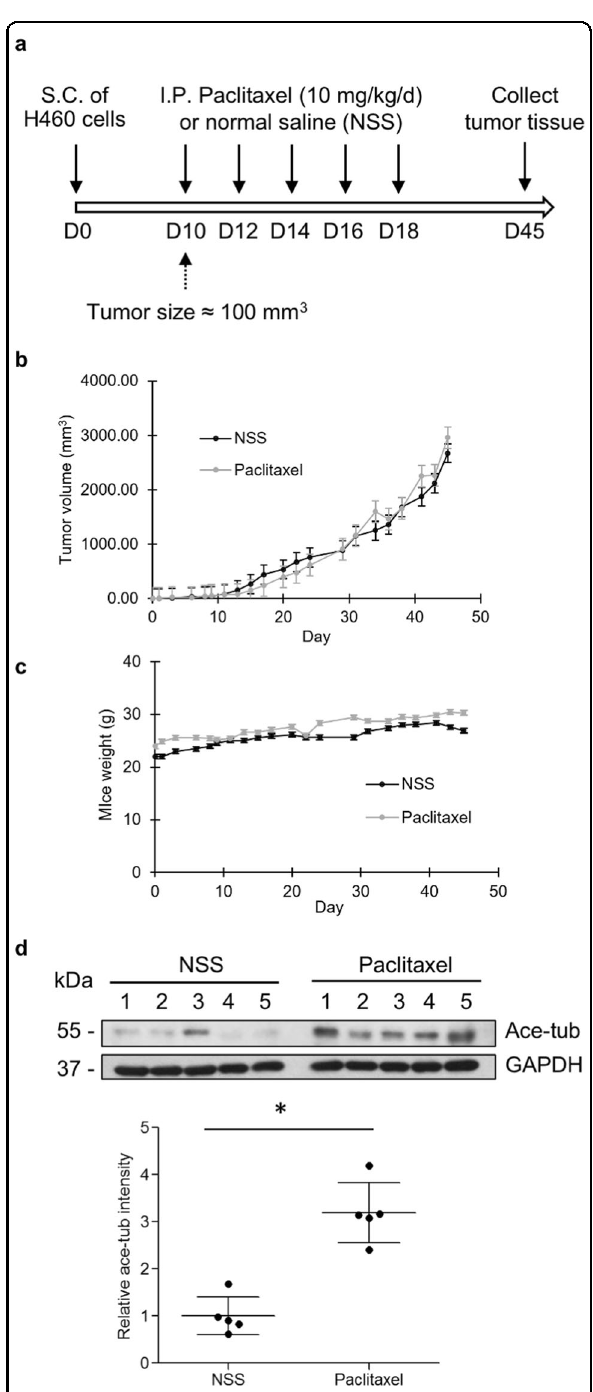
Fig. 2 Paclitaxel responsiveness in an in vivo xenograft immunode fi cient mouse model. a Scheme demonstrating the time course of drug administration. S.C. subcutaneous injection, I.P. intraperitoneal injection. b Tumor volume and c mouse weight of the paclitaxel- and normal saline (NSS)-treated groups. Plots represent the mean ± SEM from fi ve mice. d After 30 days of paclitaxel administration, tumor nodules from the NSS- and paclitaxel-treated groups were collected, and acetylated tubulin (Ace-tub) expression was examined by western blot analysis. The blots were reprobed with GAPDH to con fi rm equal loading. The graphs show the mean ± SEM of the relative Ace-tub intensity. Student ’ s t test, * P < 0.05 vs NSS- treated group ( n =